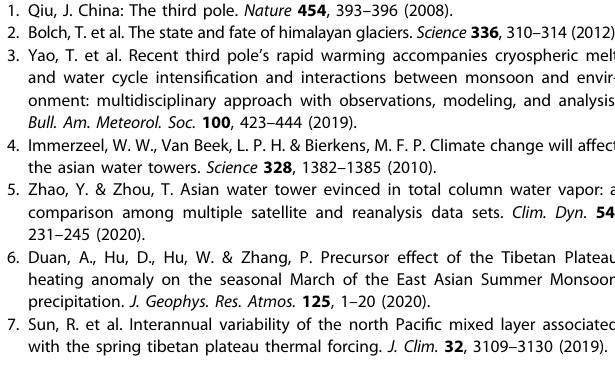
Fig. 4 Contribution of BKS sea ice loss to the TP winter warming. Ratios of warming trends between the BKS experiment and multiple datasets during the period of 1979 –